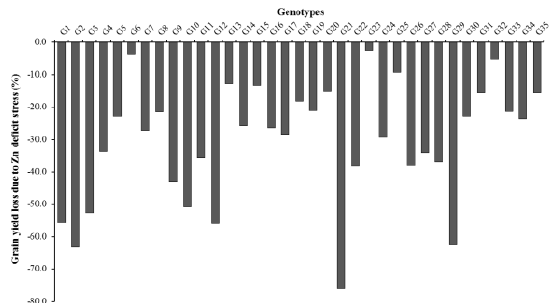
Fig. 2. Percent of grain yield (GY) reduction between environmental conditions with and without zinc deficit stress of 35 durum wheat genotypes. The numbers inside the figure are genotypes codes (see Table 1). Fig. 3. The relationship between grain yields